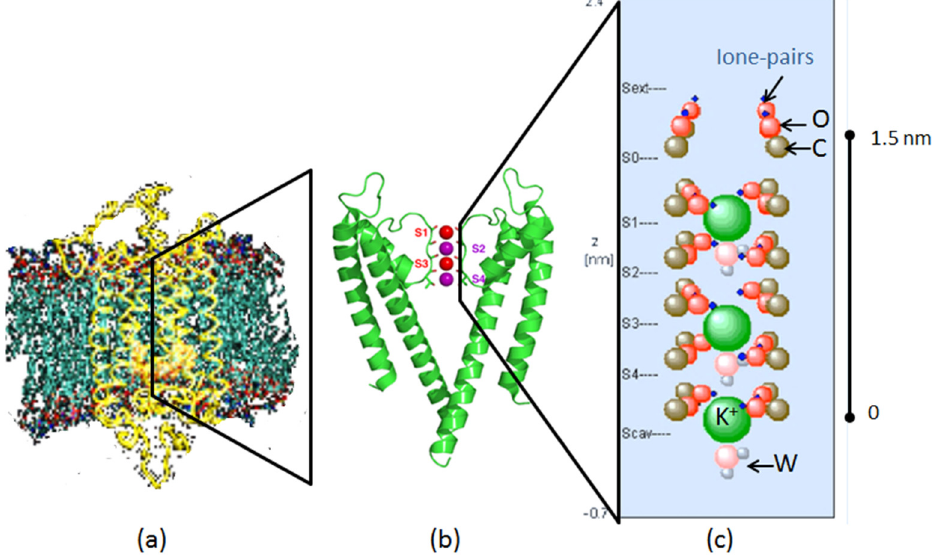
Figure 1. ( a ) The KcsA channel embedded in the cell membrane and surrounded by the lipid bilayer (adapted from [13] and modified from [14]). Protein as yellow ribbons, lipid tails as chains, water as sticks and K + and Cl-ions as red and grey balls, respectively. ( b ) A stripped view of the KcsA channel with the mechanical gate at the bottom and the selectivity filter occupied by K + ions (red and magenta) in the upper part. Only two strands of the tetrameric protein structure are shown. ( c ) The selectivity filter occupied with a sequence of K + ions (green) and H 2 O molecules (pink and grey) in the K1WK3W configuration, with an additional K + ion and a water molecule entering the filter from the cavity (S cav ).